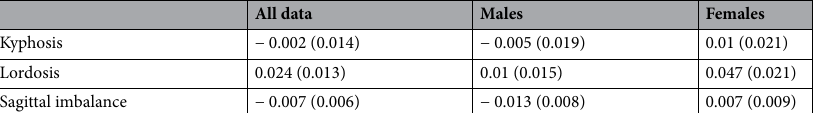
Table 2. The fixed coefficients (with standard error in brackets) of the models for both types of main coronal asymmetry.